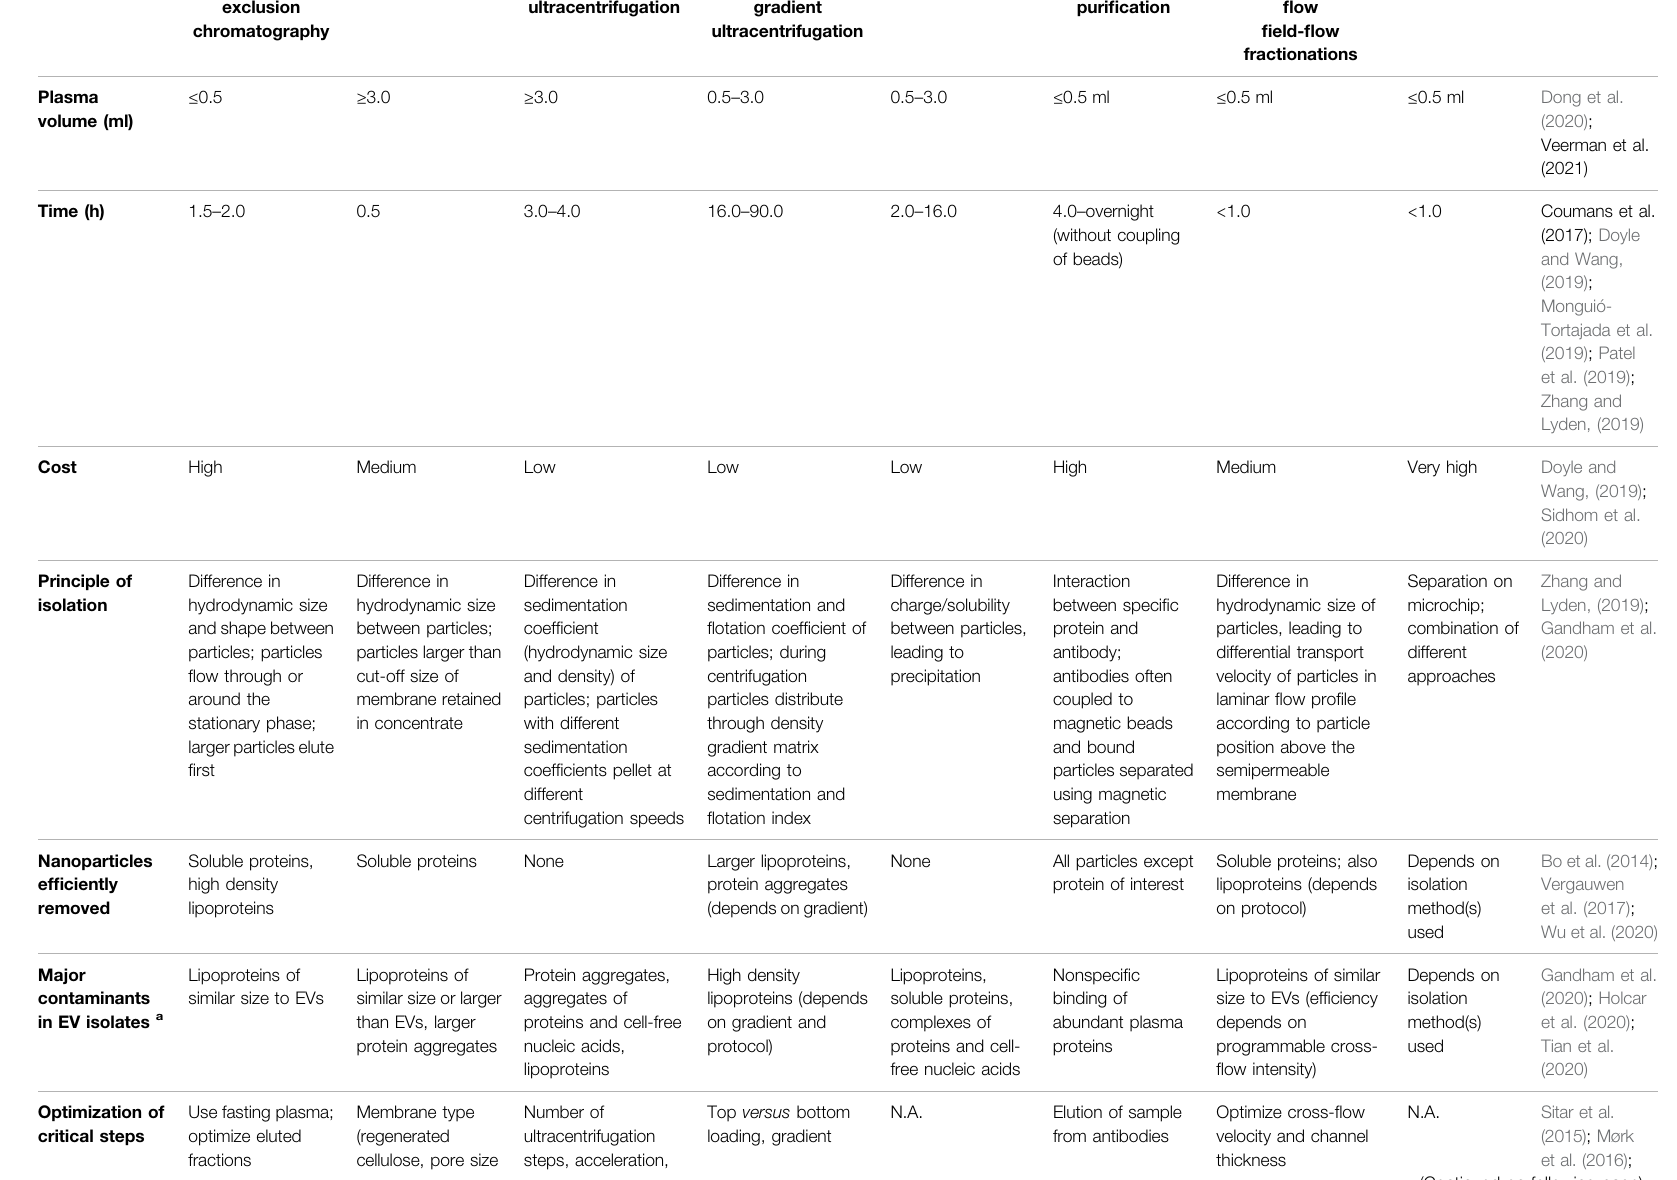
TABLE 2 | Characteristics of the most commonly used methods for isolation of extracellular vesicles (EVs) from human